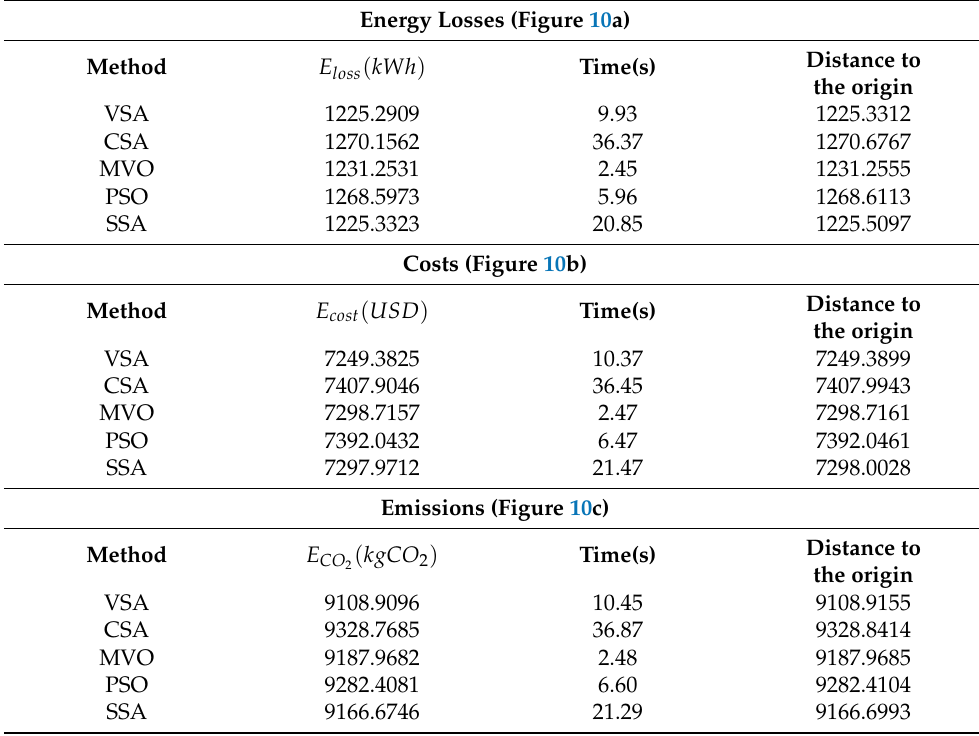
Figure 9. Average reductions, standard deviation, and average processing time obtained by optimiza- tion methods in economical, technical, and environmental conditions used in standalone network. Table 12. Average objective function solution vs. average processing time in standalone